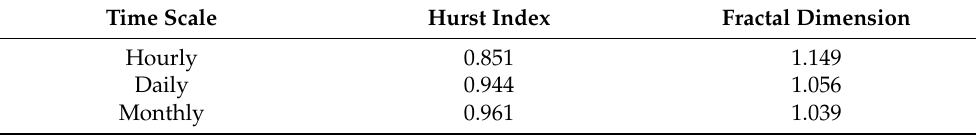
Table 2. Hurst index and fractal dimension of the EDH time series at different timescales.